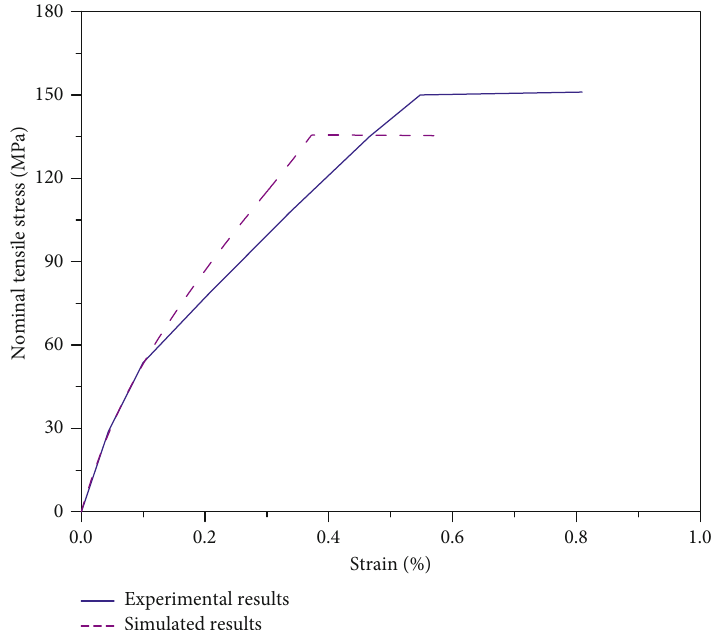
Figure 5: Comparison of simulated tensile stress and strain relationship with experimental results in Li [13] for 2D woven C/SiC composite open-hole plate.